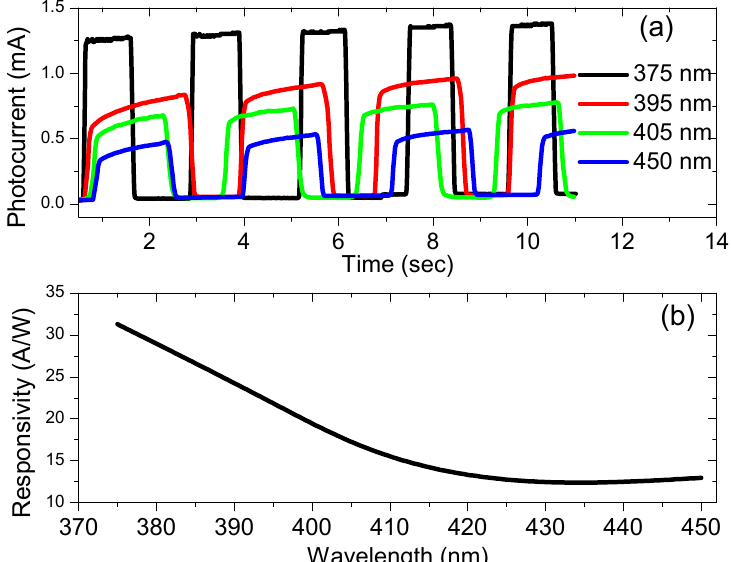
Figure 15. ( a ) The current-time characteristic for four different wavelengths and ( b ) the photo- response of the AgNWs/P-Si photodetector versus wavelength.